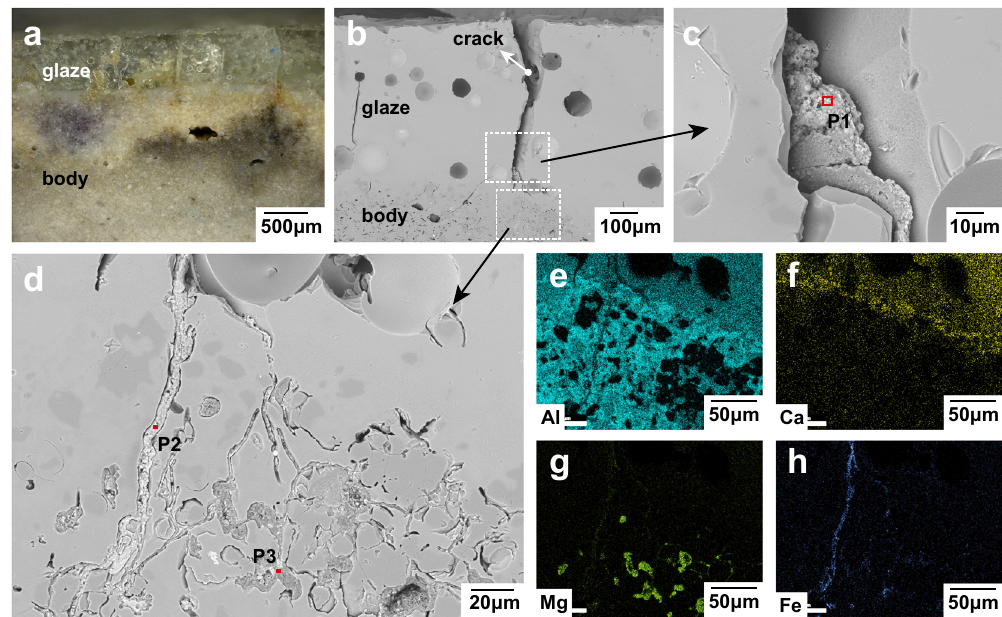
Fig. 5 The contaminants in sample No. 06. a and b are OM and SEM images of the polished cross section, respectively; c yellow substances in a crack: rectangular area in b ; d the contaminants in a crack near glaze-body interface: rectangular area in b ; e – h are the EDS mapping results of d .